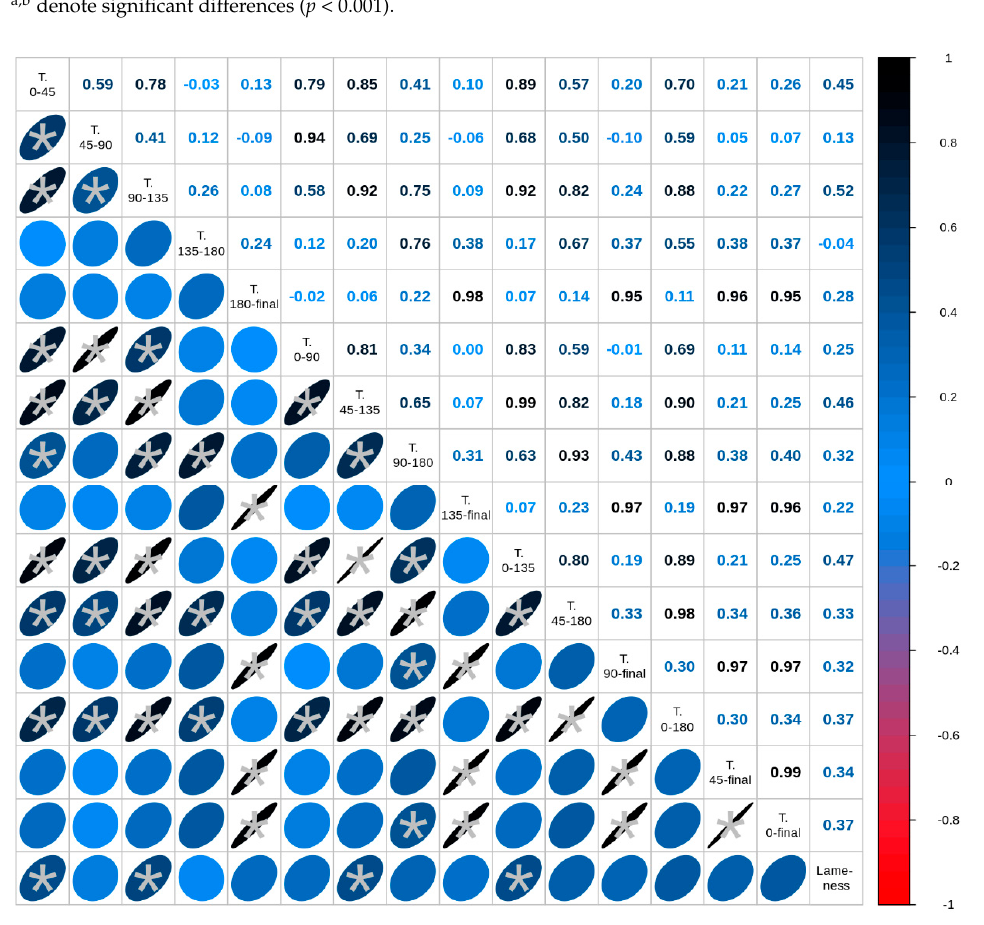
Figure 1. Correlations between average daily gain, calculated at different time intervals (T), and lameness at 3.5 years of age in a colony of sows (N = 25) produced by assisted reproductive technolo- gies. The matrix shows the Spearman’s Rho correlation. The color and form of the ellipse indicate the correlation strength (s). Red means negative and blue means positive correlation. The rounder the ellipse the lower the correlation. The asterisk indicates a significant correlation between the two parameters ( p < 0.05).